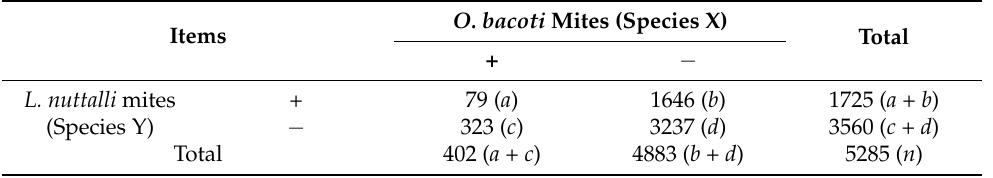
Table 10. The contingency table for measuring the interspecific association between O. bacoti mites and L. nuttalli mites on the body surface of R. tanezumi rats in Yunnan, Southwest China (1990–2015).